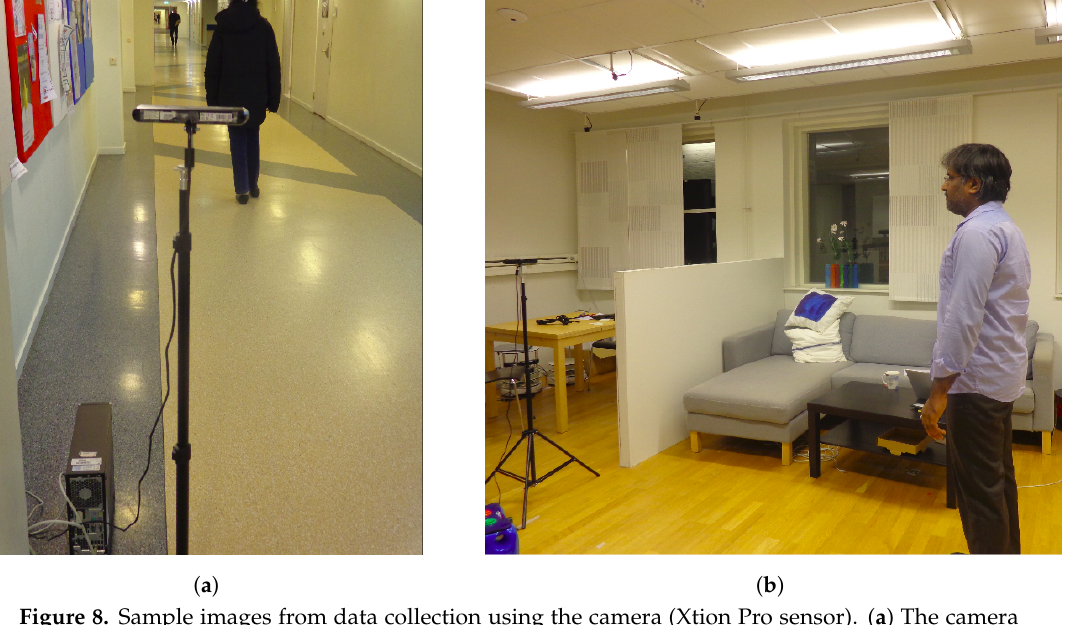
Figure 8. Sample images from data collection using the camera (Xtion Pro sensor). ( a ) The camera setup for data collection in corridor setting to obtain real distance and Euclidean distance between ear and torso points. ( b ) The camera setup for data collection in laboratory setting to obtain depth information with predefined true distance for sensor noise analysis, Table